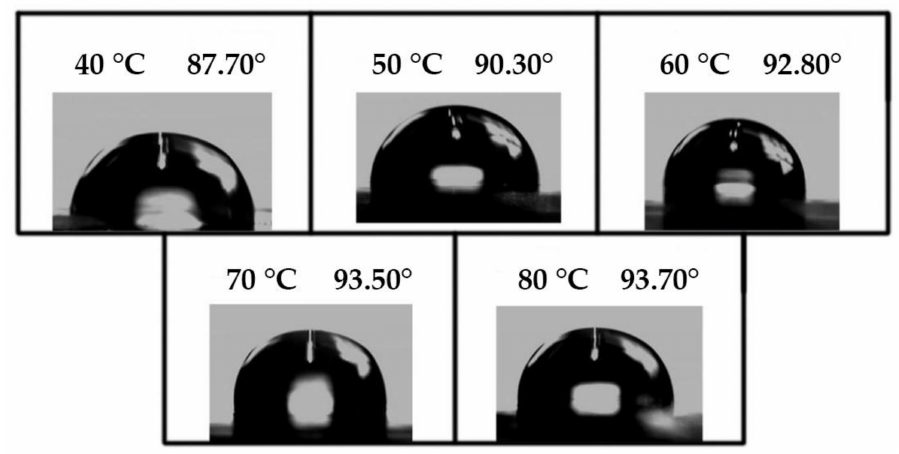
Figure 16. Water contact angles of SPU films with different film forming temperatures.